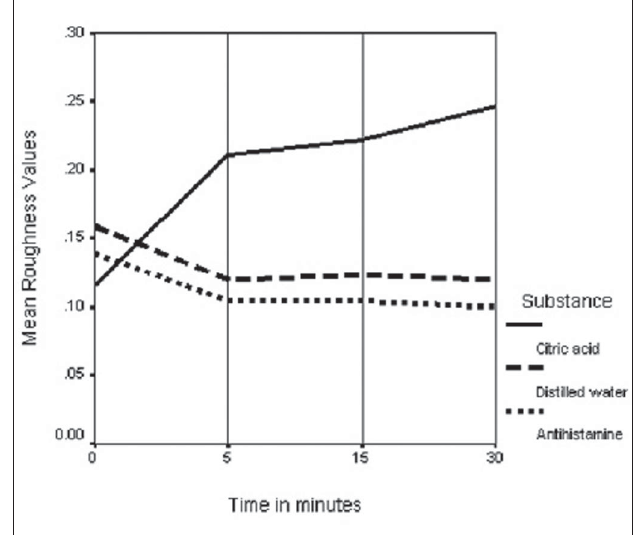
Fig. 1 – Mean roughness values of bovine enamel specimens according to media and exposure time